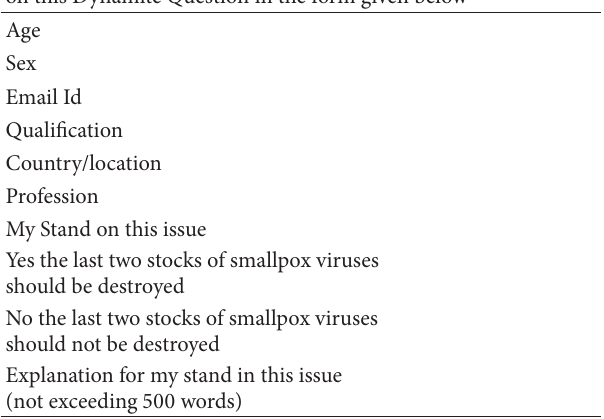
Table 1: Questionnaire given to the participants of the inquiry on the option of preserving/destroying the variola